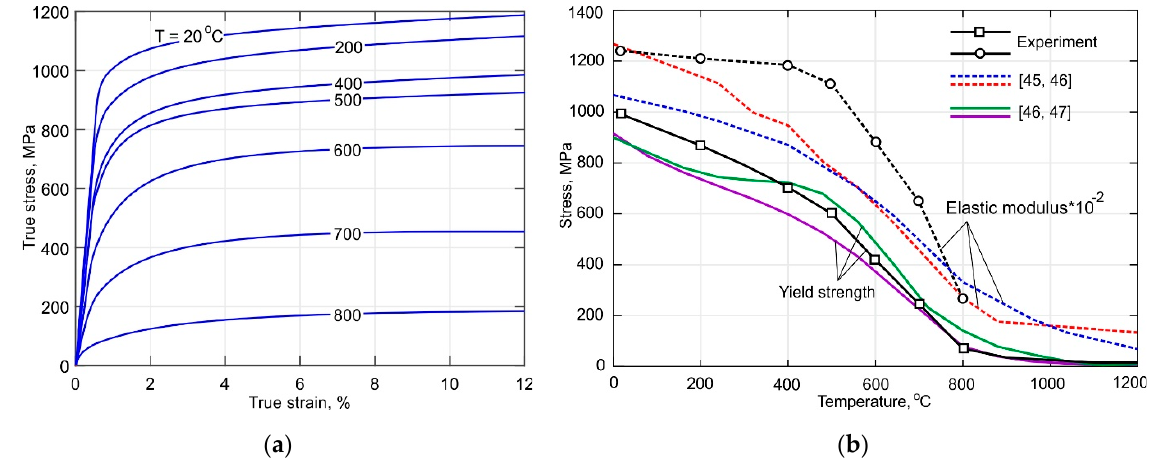
Figure 3. ( a ) True tensile curves of the DLD-processed Ti-6Al-4V alloy; ( b ) comparison of the measured yield strength and Young’s modulus with published data from [45–47].